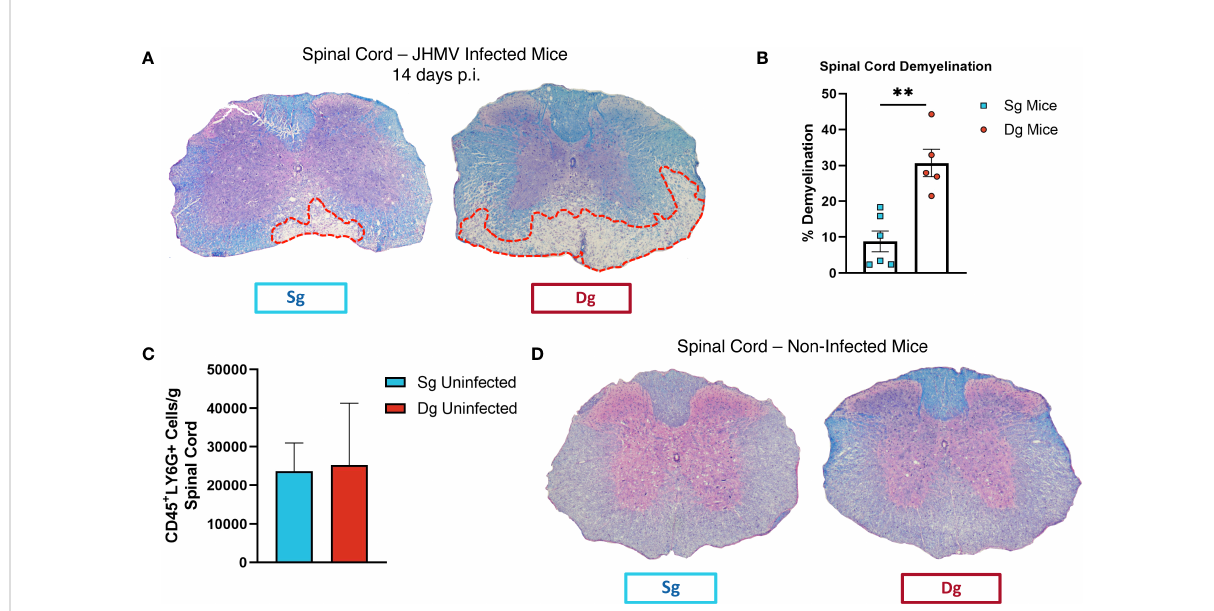
FIGURE 2 Demyelination is increased in doxycycline-treated double-tg infected with JHMV. (A) Representative H&E/LFB-stained spinal cord sections from doxycycline-treated double-tg and single-tg mice infected with JHMV at day 14 p.i. reveals increased spinal cord demyelination (red dashed line) in double-tg mice compared to single-tg mice. (B) Quanti fi cation of demyelination severity indicates white matter damage is signi fi cantly (p < 0.01) more severe in infected double-tg mice (n = 5) compared to single tg mice (n = 6); data is derived from 2 independent experiments. **p < 0.01. (C) Flow cytometric analysis of neutrophils present in the spinal cords of uninfected doxycycline-treated single-tg mice (n = 3) and double-tg mice (n = 3) shows no signi fi cant difference in neutrophil numbers between experimental groups. (D) Representative H&E/LFB-stained spinal cord sections from uninfected doxycycline-treated single-tg mice (n = 4) and double-tg (n = 4) reveals no evidence of demyelination.